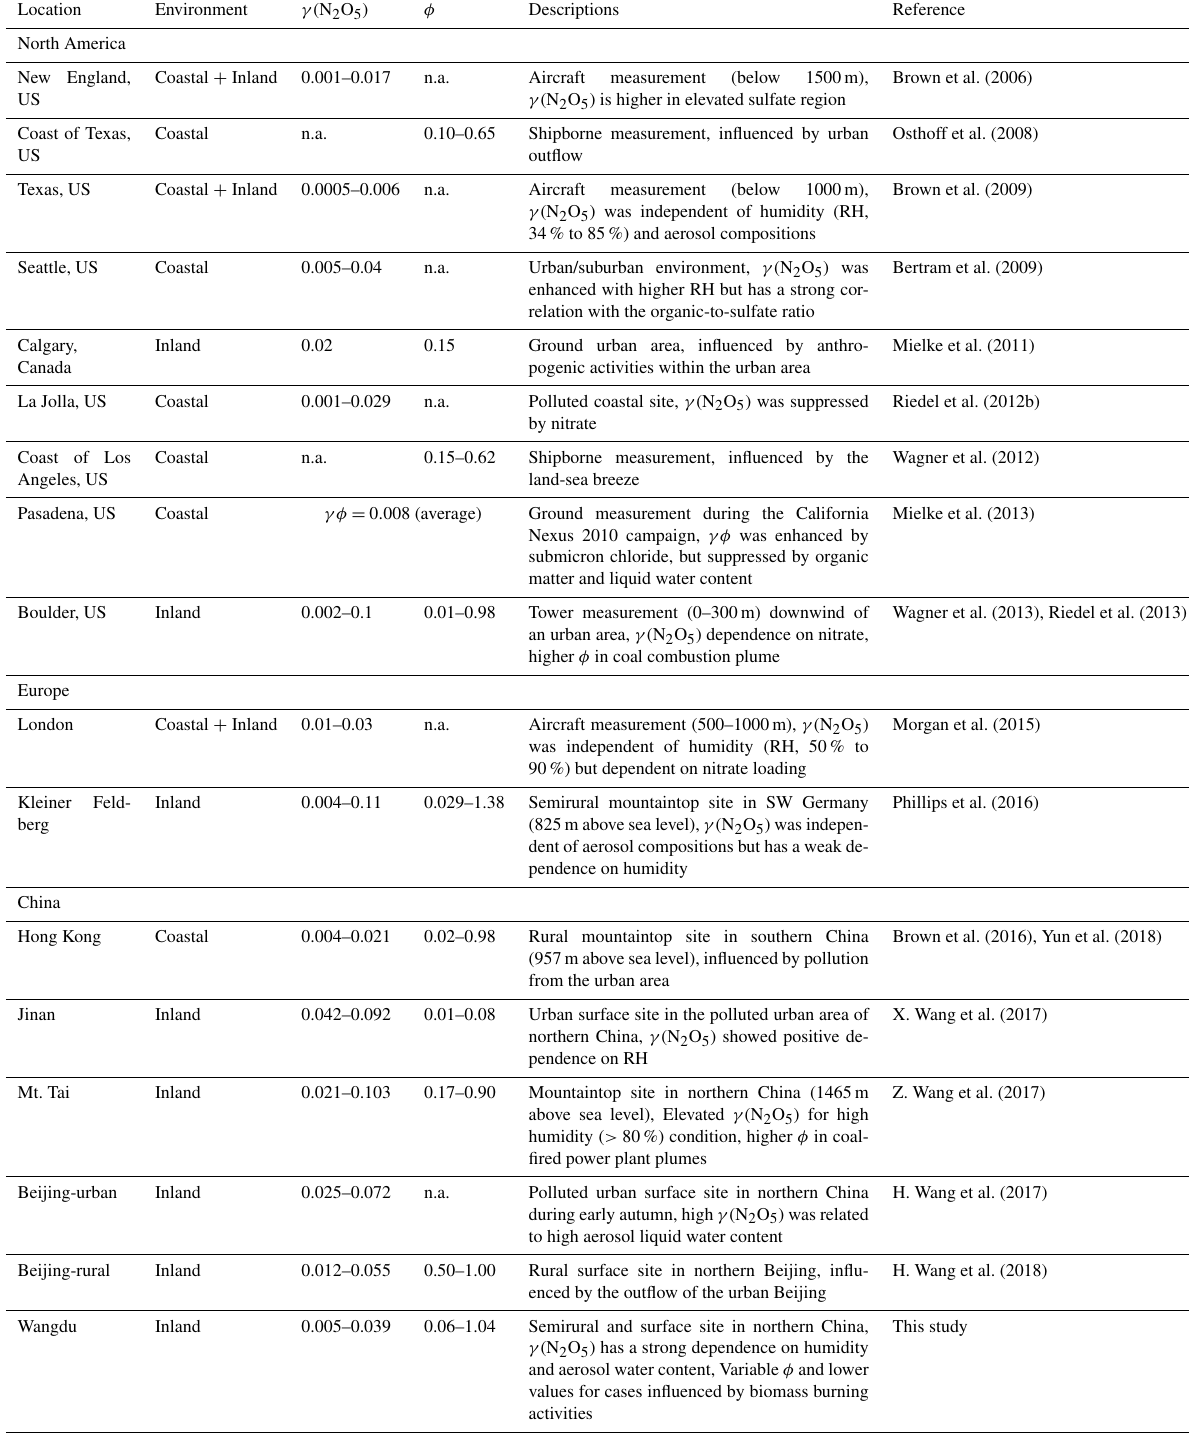
Table 2. Summary of field-observed N 2 O 5 uptake coefficient and ClNO 2 yield from previous studies.